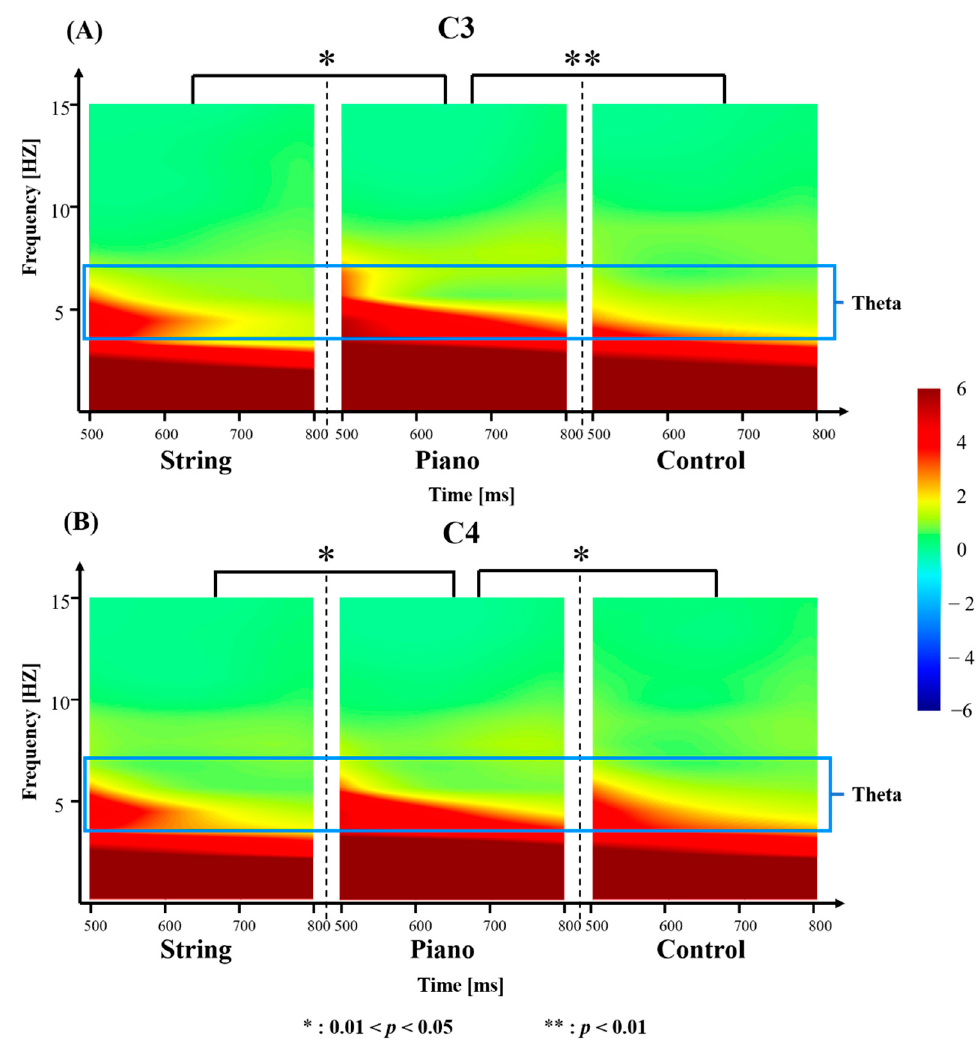
Figure 4. ( A ) Group mean difference between three groups (string musicians showed as String